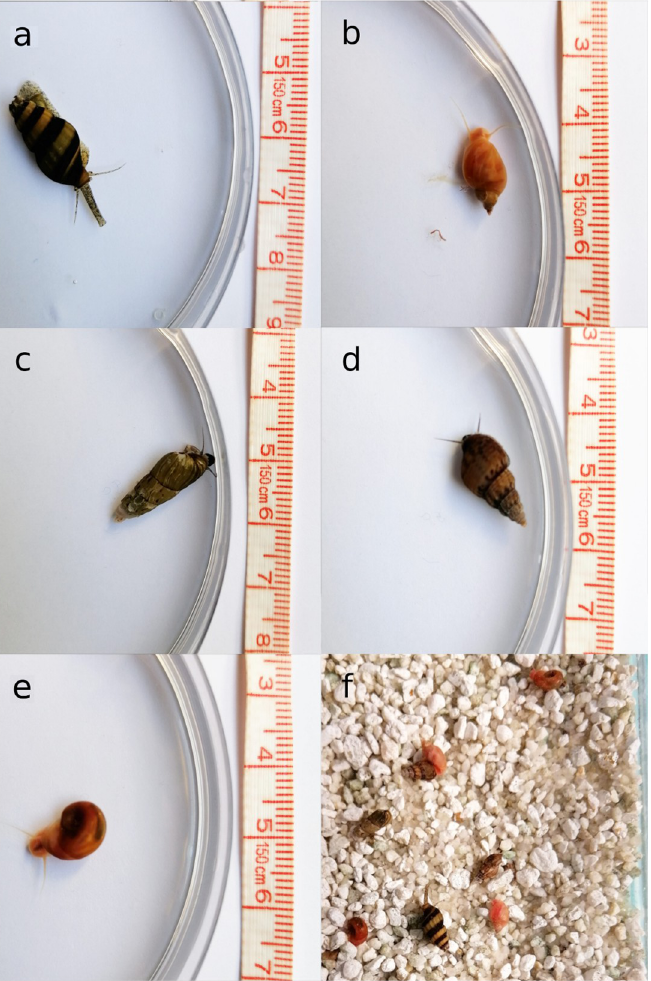
Fig 1. Overview of snail species used in the experiment. Snail species used in the experiment with their characteristic body shapes. Prey snail species used in the experiment with A. helena (a) include: Pond snails ( Lymnaea sp.; b), Trumpet snails ( Melanoides tuberculata ; c), Quilted Melania snails ( Tarebia granifera ; d), and Ramshorn snails ( Planorbella sp.; e). Top-down view of a typical experimental compartment (f) containing the predator and the four types of prey (in equal relative abundances). Note that panel f is on a different scale from the other panels, roughly 2:1. Photos credit: Oksana Gonchar (University of Leicester, UK). ( Melanoides tuberculata ), Pond snails ( Lymnaea sp.), and Quilted melania snails ( Tarebia granifera ; Fig 1b–1e). These were also selected for their different morphologies and behaviours,